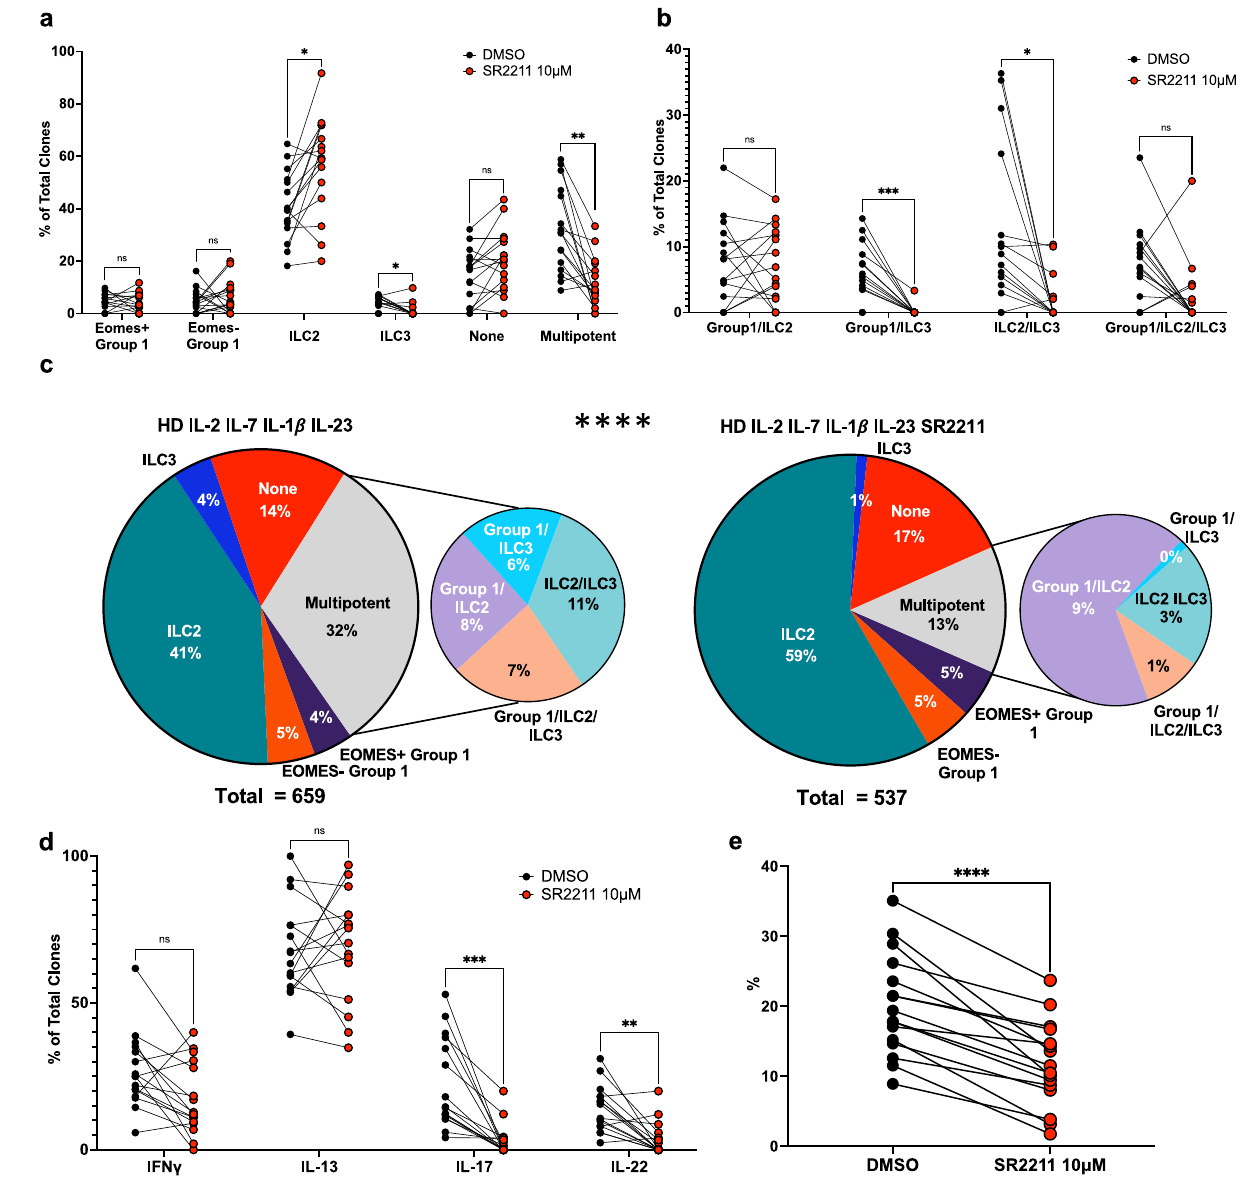
Fig.4|ImpactofSR2211onclonalILCPdifferentiation. SingleILCPfromhealthy donors ( n =16) were cultured with either 0.01% DMSO (black circles) or